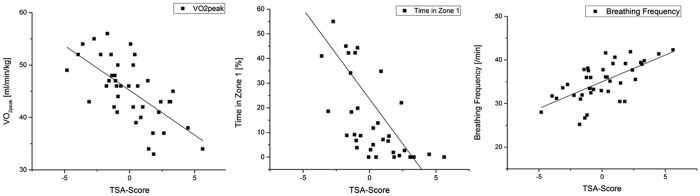
Relationship between the three main performance predictors and TSA-scores identified by multiple regression: relative VO2peak (left), time in Zone 1 (middle) and breathing frequency (right).